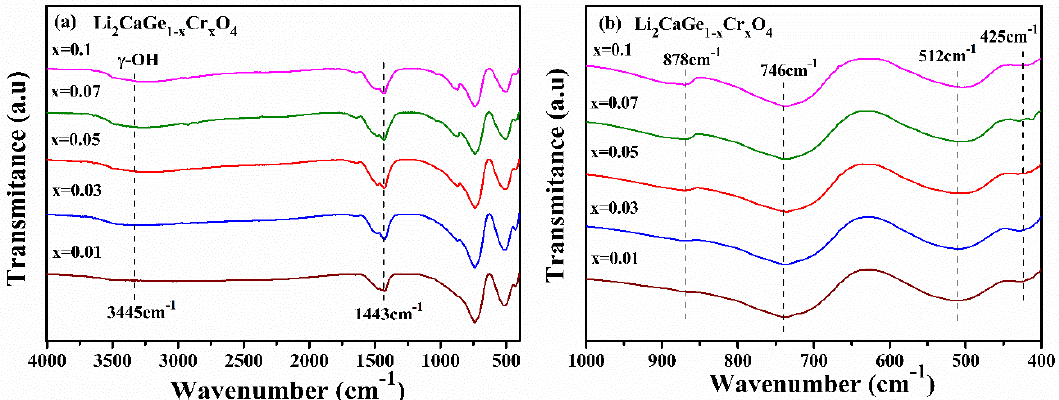
Figure 4. Fourier infrared spectra of Li 2 CaGe 1 − x Cr x O 4 (x = 0.01, 0.03, 0.05, 0.07, and 0.1): ( a ) FT-IR spectrum in the range of 4000–400 cm −1 ; ( b ) FT-IR spectrum in the range of 1000–400 cm −1 .